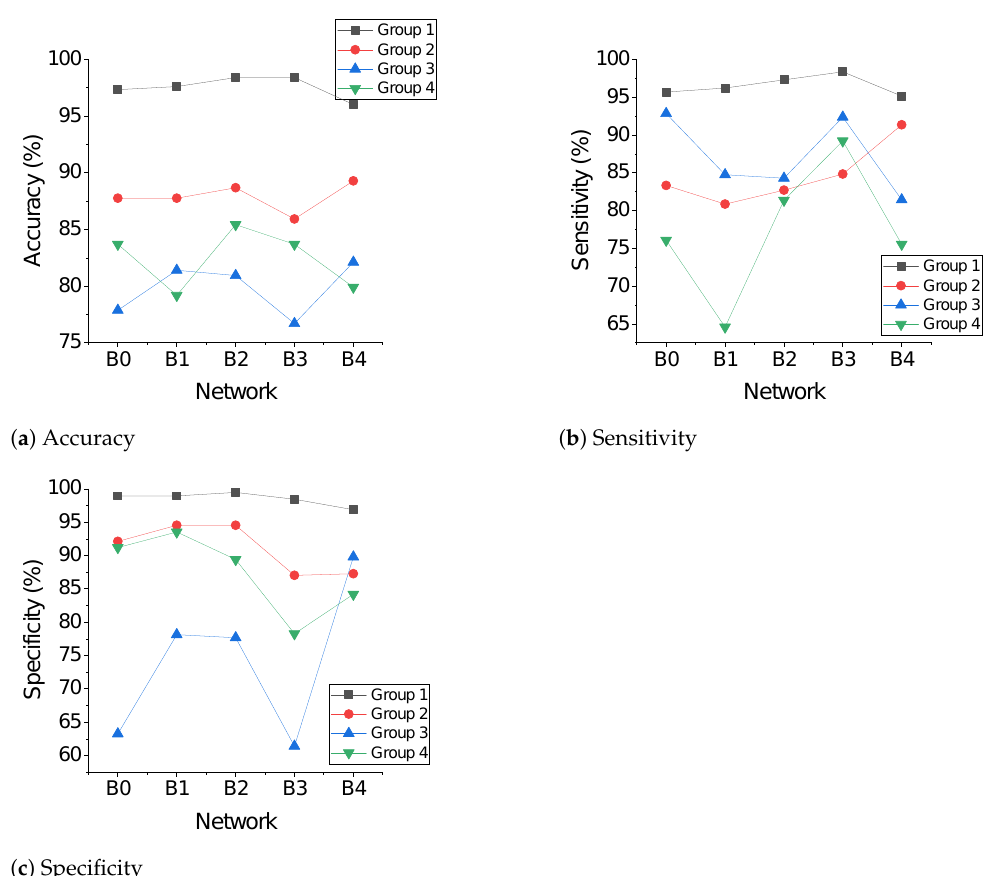
Figure 9. When the network is scaled, comparing the classification performance of Group 3 and other groups in the interpatient